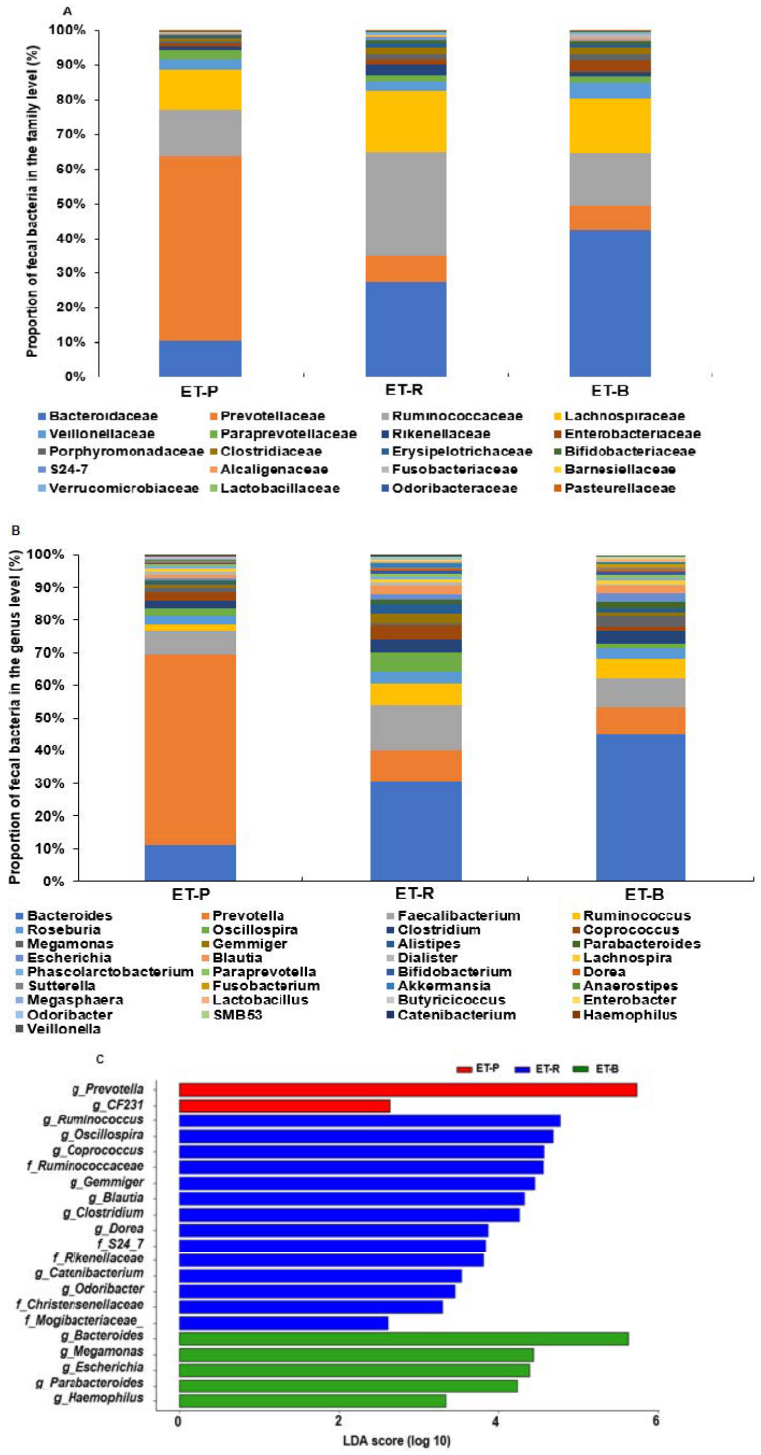
Figure 3. The relative abundance of the fecal bacteria in each enterotype at the ( A , B ) family level and genus level. ( C ) Primary bacteria in genus level by operational taxonomic unit (OTU)-based linear discriminant analysis effect size (LEfSe) analysis with the logarithmic discriminant analysis (LDA) score threshold >2.0 that was statistically significant at p < 0.05. ET-P, Prevotellaceae ; ET-R, Ruminococcaceae ; ET-B, Bacteroidaceae . The ET-R and ET-B contained significantly higher numbers of Bifidobacteriales than ET-P at the order level (Table 3). At the species level, ET-R had a significantly higher proportion of Akkermansia muciniphila compared to ET-P and ET-B. ET-R had a significantly higher proportion of Bifidobacte- rium adolescentis compared to ET-P and ET-B (Table 3). ET-R also had a significantly higher propor- tion of Faecalibacterium prausnitzii than ET-B, which was significantly lower in ET-P ( p < 0.05). ET-P had the highest numbers of Prevotella copri compared to other enterotypes ( p < 0.05) (Table 3). ET-R exhibited the highest species richness (Chao1) and species evenness (Shannon), while ET-B showed the lowest number of species among all enterotypes (Figure 4A,B; p < 0.05).